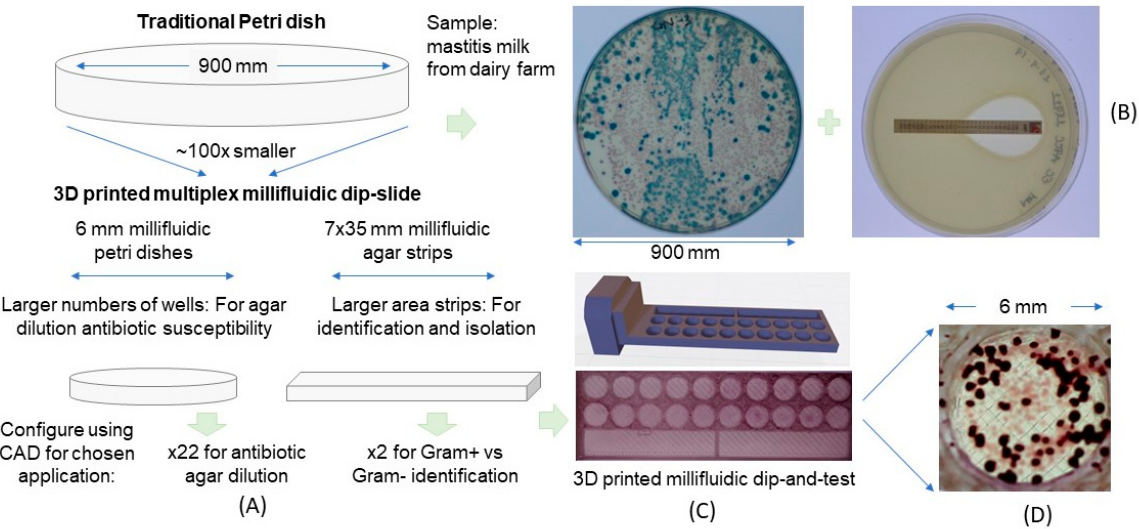
Figure 1. Shrinking Petri dishes . Miniaturized 3D-printed arrays for solid microbiological media. ( A ) Illustration of how a conventional Petri dish can be shrunk into a frame designed with different areas depending on required function. Smaller circular wells are used for antibiotic agar dilution, whereas longer strips are better suited to identification and colony isolation. ( B ) Examples of identification of bacteria and antibiotic susceptibility testing using a conventional Petri dish. ( C ) CAD illustration and photograph of 3D-printed frame for customized multiplex dip slide. ( D ) Zoomed- in image showing small bacterial colonies grown on individual wells of the 3D printed dip-slide frame.